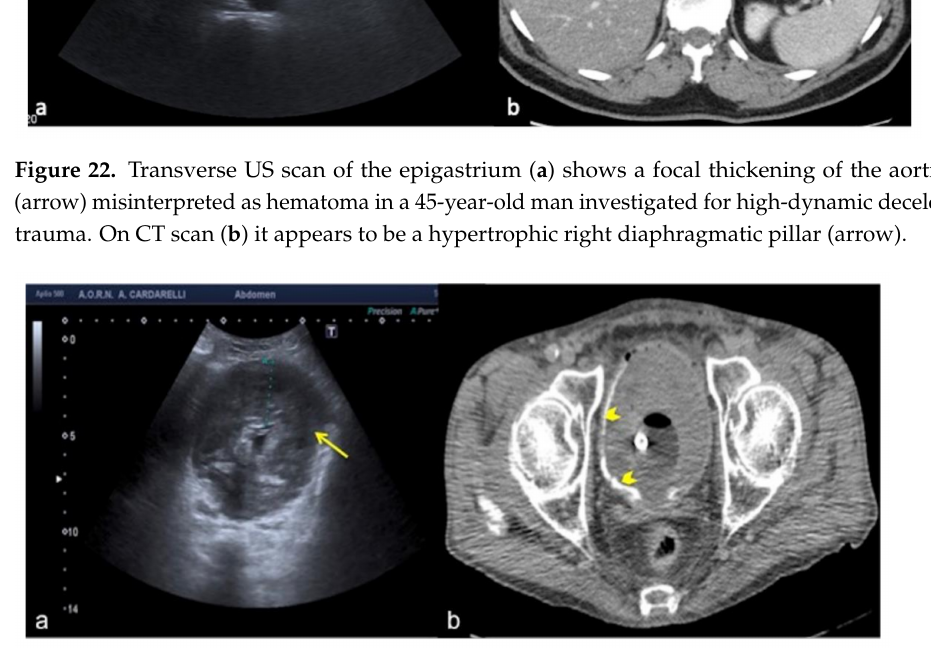
Figure 23. Transverse US scan of the bladder ( a ) shows a diffuse thickening of the wall (arrow) in a 78-year-old man investigated for hematuria. On CT scan ( b ) it appeared to be a large blood clot occupying the entire lumen of the bladder (arrowheads).